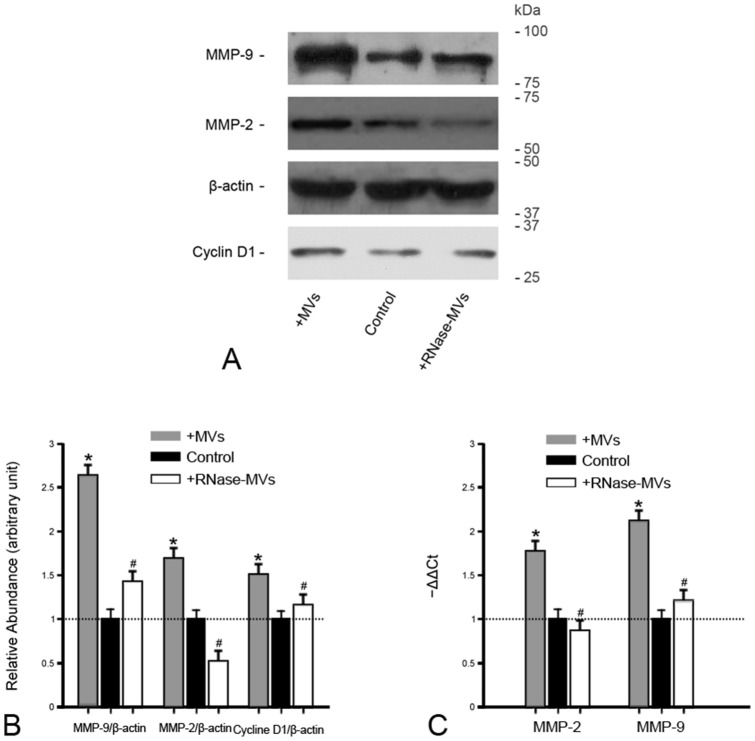
MVs enhance the expression of cyclin D1, MMP-2 and MMP-9 in tumor tissues.
(A)(B) Gel photograph and densito-metric analysis of cyclin D1, MMP-2 and MMP-9 protein expression. MVs led to a significant up-regulation of cyclin D1, MMP-2 and MMP-9 protein expression in tumor tissues. RNase pretreatment destructed these effects. The density of each band was determined. Values in the graph are expressed as densitometry ratios of cylin D1/β-actin, MMP-2/β-actin or MMP-9/β-actin as folds over control (dotted line). Data were obtained from 3 animals for each experiment. *P<0.05, MVs vs. control; #
P<0.05, RNase-MVs vs. MVs; (C) Gene expression of MMP-2 and MMP-9. The gene expression of MMP-2 or MMP-9 was markedly up-regulated by MVs. The Ct (threshold cycle) for each gene was determined for each sample. The quantification of MMP-2 or MMP-9 was normalized by β-actin. The gene expression in control group was regarded as the calibrator (dotted line).The relative expression of the target gene was calculated by 2−ΔΔCt. *P<0.05, MVs vs. control; #
P<0.05, RNase-MVs vs. MVs.